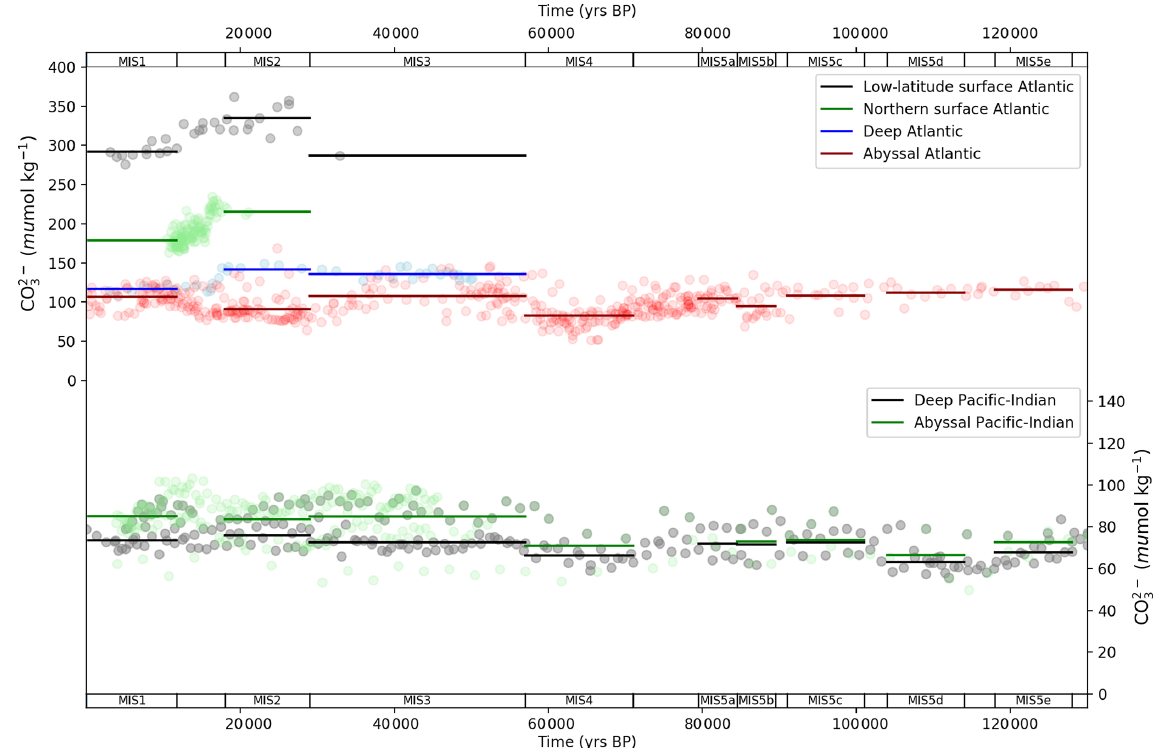
Figure 7. MIS stage ocean data mapped into box model dimensions for carbonate ion proxy. Data (round circles) are mapped into deep (2500m average depth) and abyssal (3700 (Atlantic)–4000m (Pacific–Indian) average depth) model boxes and averaged across MIS slices (bold lines). Data behind the figure are shown in Table